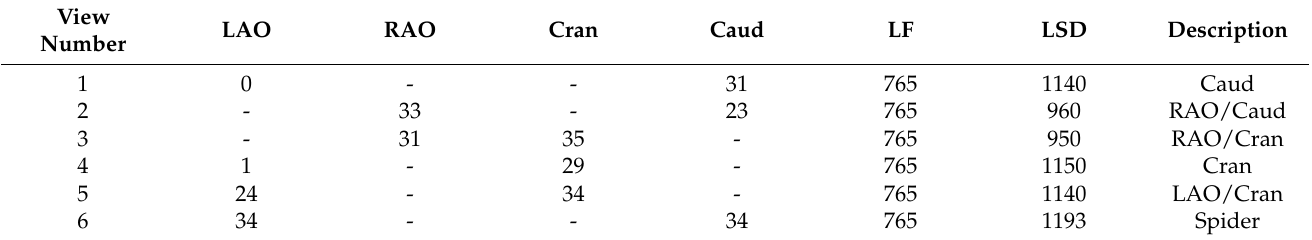
Table 1. Description of views used for digital angiograms.